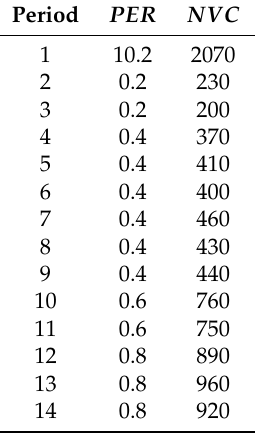
Table 3. Parameters associated with the wildfire evolution: perimeter and cost (abbreviations are defined in Section